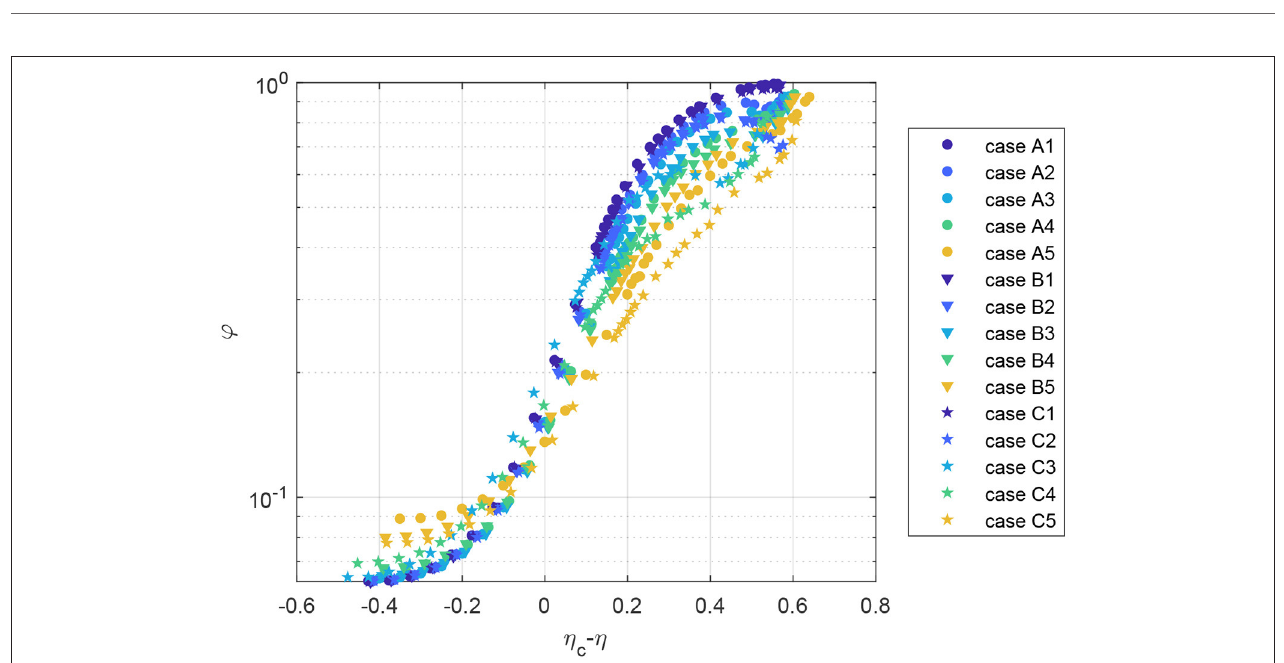
FIGURE 3 | Mean steady-state polarization ϕ as a function of the distance from the critical noise η c for fifteen obstacle